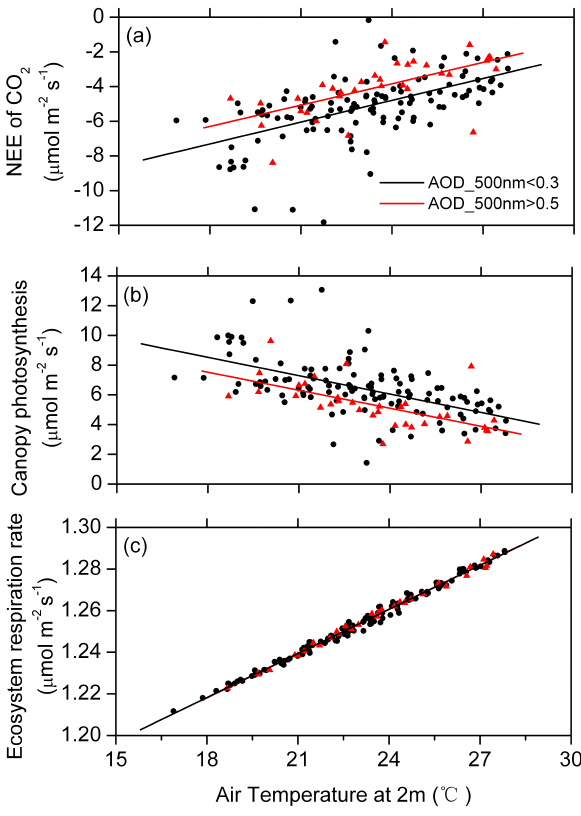
Fig. 11. Relationships between NEE of CO 2 (a) , canopy photosyn- thesis (b) , ecosystem respiration rate (c) , and clearness index for lin- ear fits. For CI > 0.65, black line: AOD < 0.3 ( n = 115, (a) r 2 = 0 . 13, (b) r 2 = 0 . 13, (c) r 2 = 0 . 20, p < 0 . 01 ) ; red line: AOD > 0.5 ( n = 28, (a) r 2 = 0 . 25, p < 0 . 01 , (b) r 2 = 0 . 25, p < 0 . 01, (c) r 2 = 0 . 11, not passing the significance test).